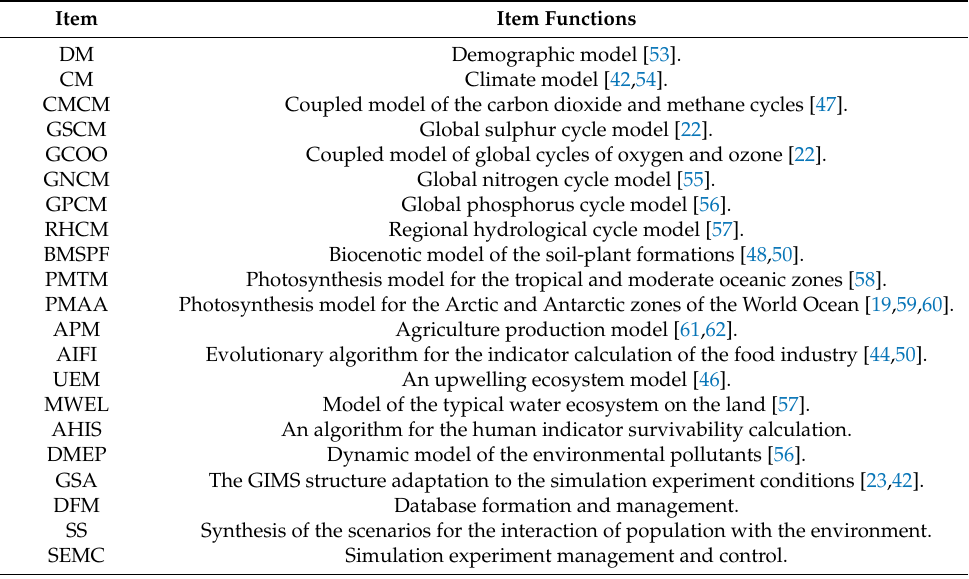
Figure 1. The GIMS/CNSS block-diagram. Abbreviation expansion is given in Table 1. Table 1. The GIMS/CNSS functional items.